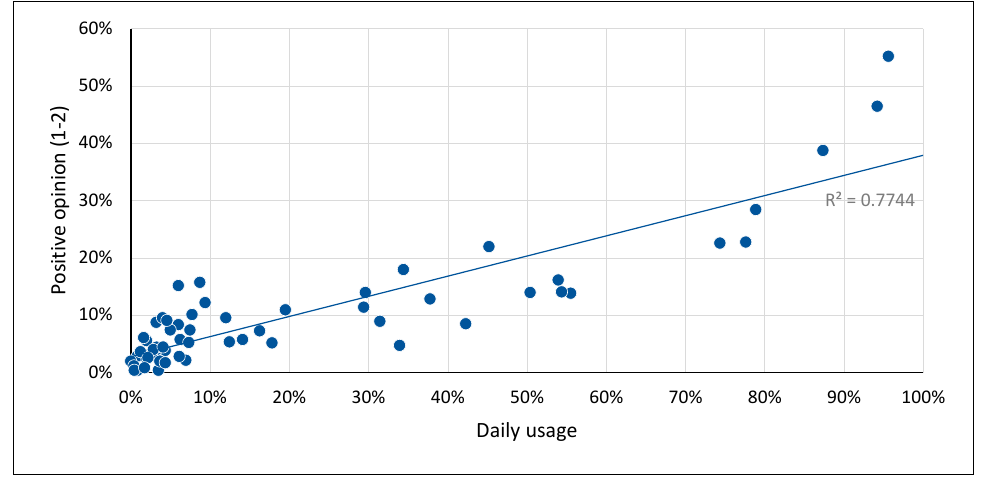
Figure 3. Positive opinion (1–2) on communication from insurer on social media by daily use.